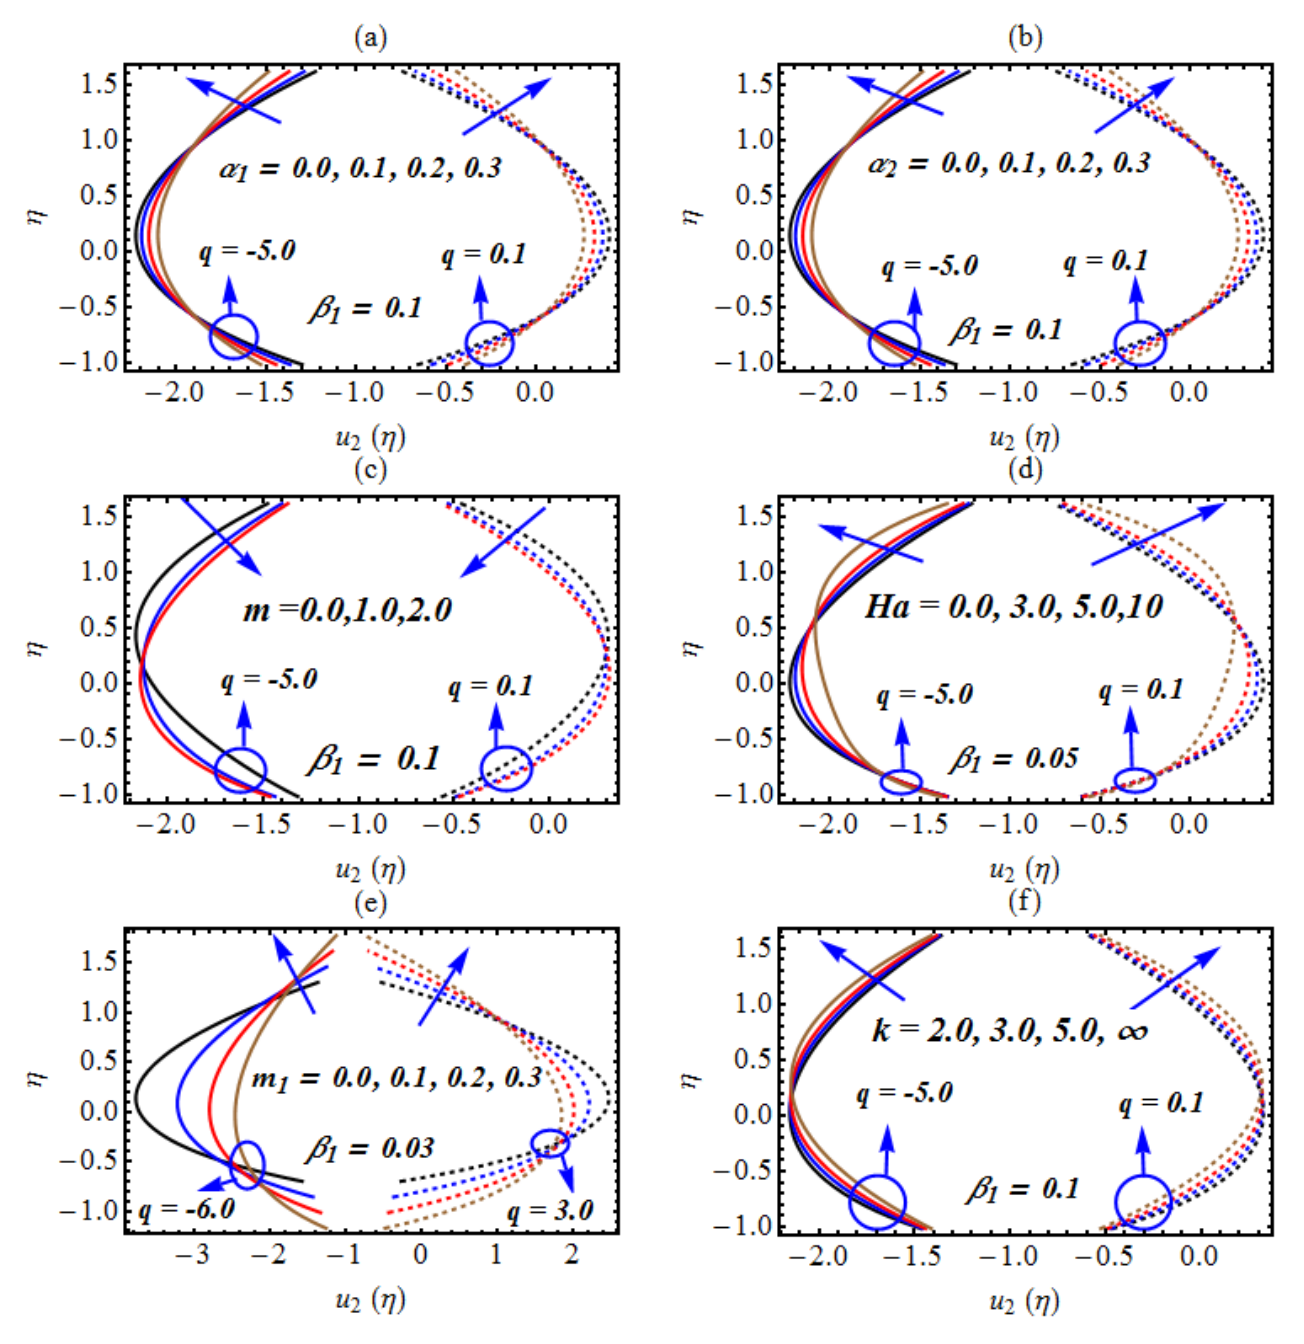
Figure 2. ( a – f ): ( a ) Change in u 2 ( η ) for α 1 , ( b ) change in u 2 ( η ) for α 2 , ( c ) change in u 2 ( η ) for m , ( d ) change in u 2 ( η ) for Ha , ( e ) change in u 2 ( η ) for m 1 , ( f ) change in u 2 ( η ) for m 1